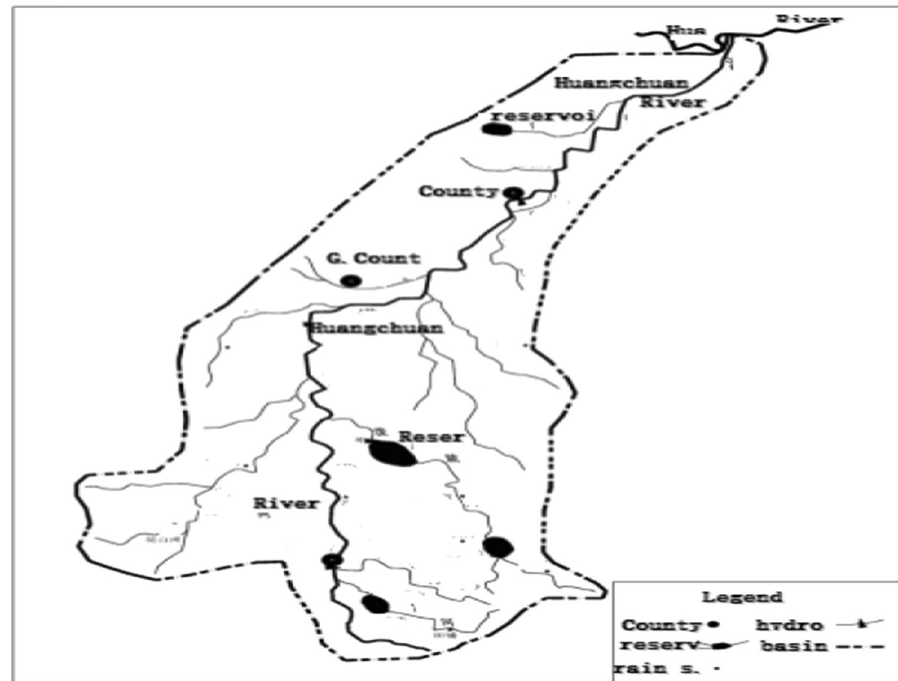
Fig. 4 Schematic diagram of Huangchuan River water